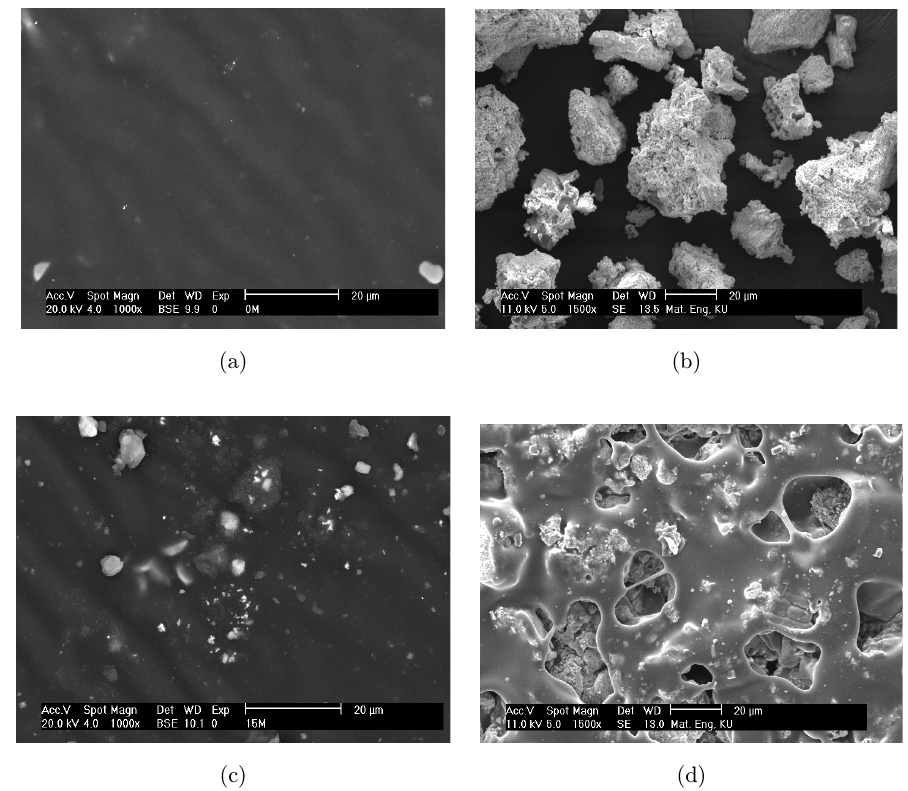
Fig. 3. SEM micrographs of: (a) natural rubber (NR-STR 5L), (b) lead zirconate (PbZrO 3 Þ , (c) NR-STR5L/PZ 5 and (d) NR- STR5L/PZ 6.